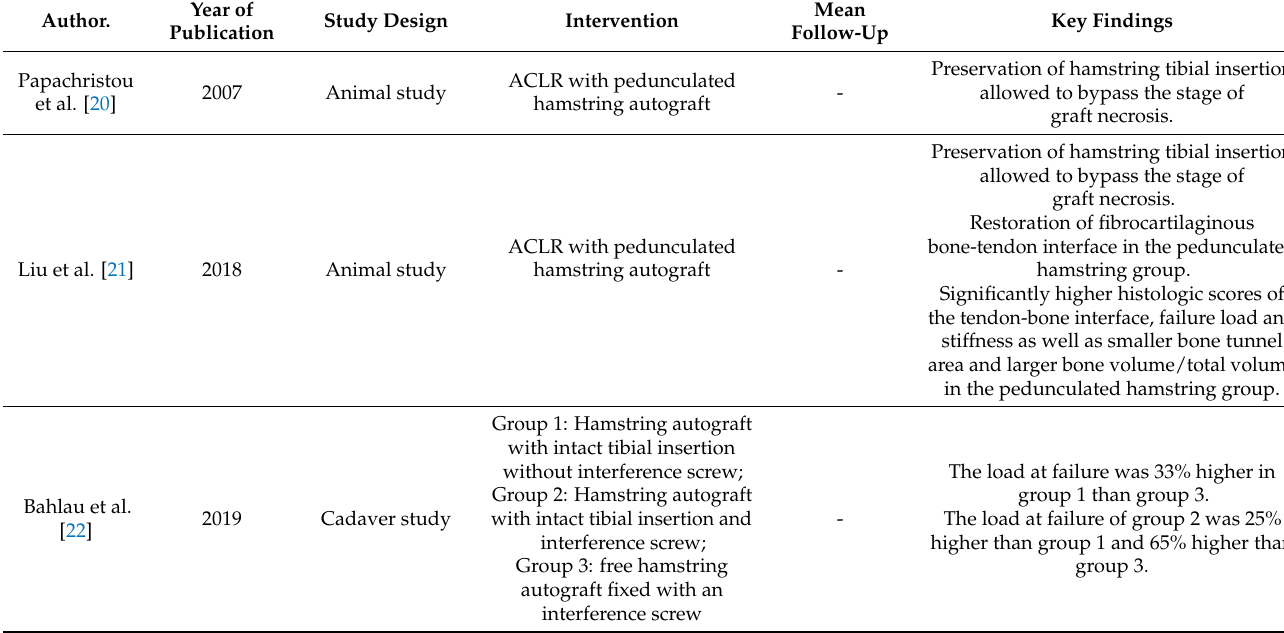
Table 2. Summary of available literature concerning ACL reconstructions with pedunculated hamstring graft (Abbrevia- tions: IKDC—International Knee Documentation Committee; ACLR—Anterior cruciate ligament reconstruction; SNQ— Signal/noise quotient; MRI—Magnetic resonance